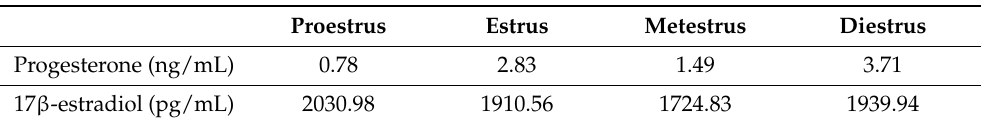
Table 5. Average progesterone and 17 β -estradiol levels during the estrous cycle of D. prymnolopha , according to Guimar ã es et al. [51]. Proestrus Estrus Metestrus Diestrus Progesterone (ng/mL) 0.78 2.83 1.49 3.71 17 β -estradiol (pg/mL) 2030.98 1910.56 1724.83